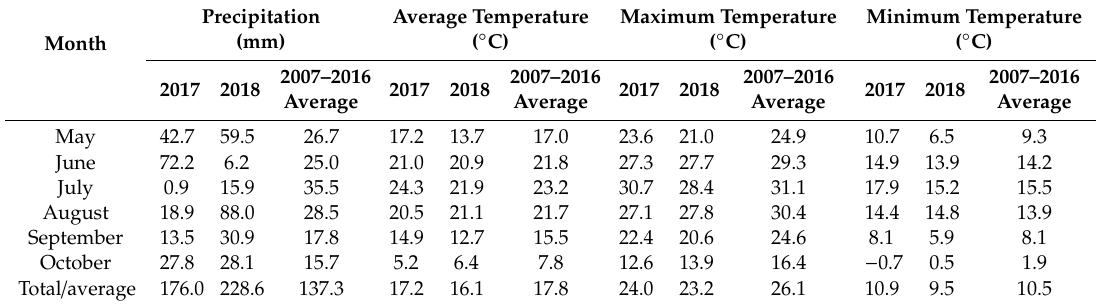
Table 1. Precipitation and air temperature during the 2017 and 2018 growing seasons.